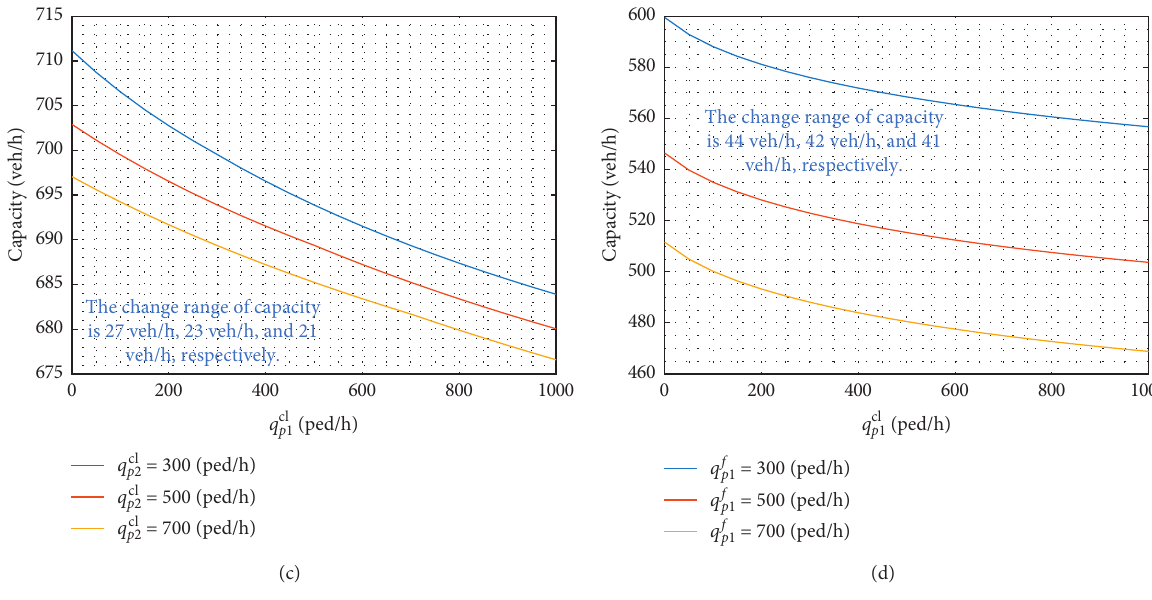
Figure 3: The sensitivity of capacity to the pedestrian arrival